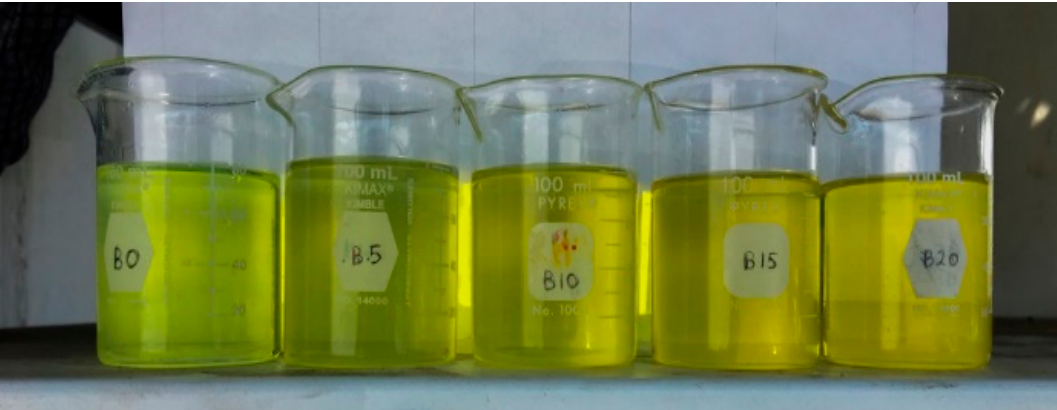
Figure 4. Connection of the network and exhaust gas analyzer.